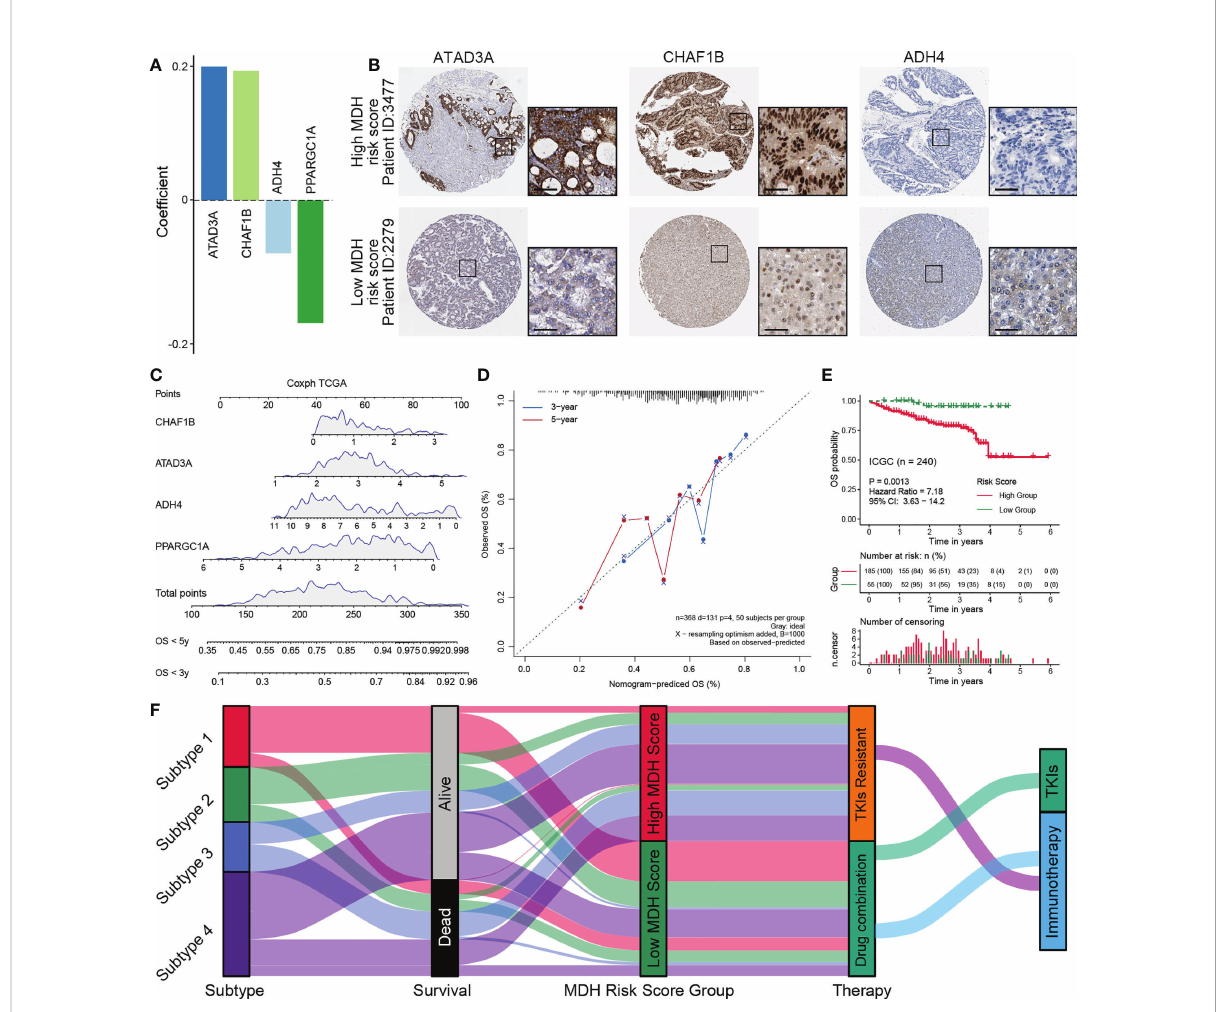
FIGURE 8 Construction of a nomogram predicting OS outcomes based on the MDH risk score in the TCGA-LIHC cohort. (A) Coef fi cients of 4 genes involved in the prognostic signatures. (B) Representative IHC images of ATAD3A, CHAF1B and ADH4 in MDH high- or low-score groups from the Human Protein Atlas. Scale bar denotes 50 m m. (C) Nomogram to predict the 3 ‐ y and 5 ‐ y overall survival of HCC patients. (D) Calibration curve for the comprehensive survival nomogram model in the TCGA-LIHC cohort. The dashed diagonal line represents the ideal situation, and the blue and red lines represent the 3 ‐ y and 5 ‐ y observed nomograms, respectively. (E) Survival analysis for the MDH risk score in the ICGC cohort. (F) Alluvial diagram showing the association of the MDH subtype with patient survival status, MDH score and individualized